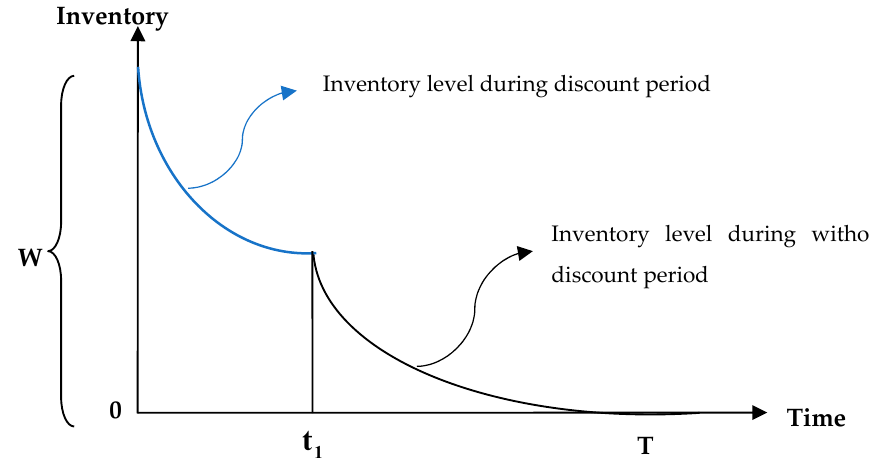
Figure 1. The electronics product inventory system with time.